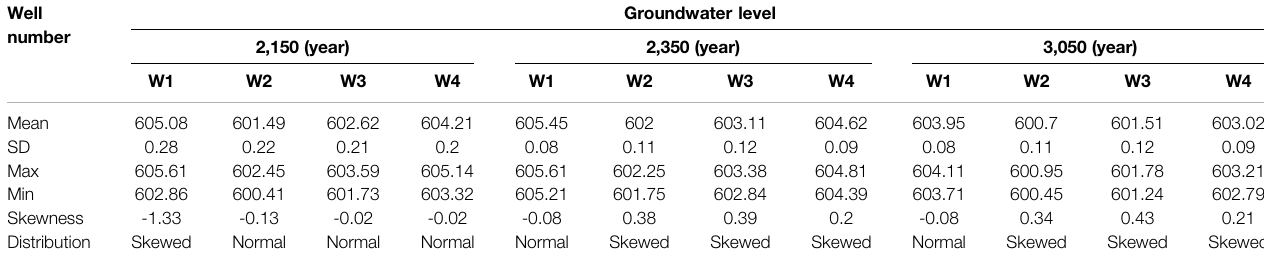
TABLE 4 | Frequency distributions characteristics of groundwater level terms predicted by three time period surrogate models. Well